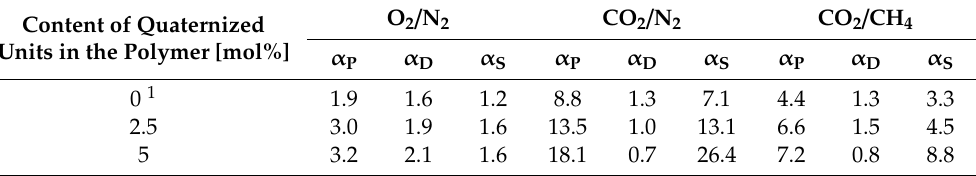
Table 5. Estimated selectivity of polymers containing butylimidazole